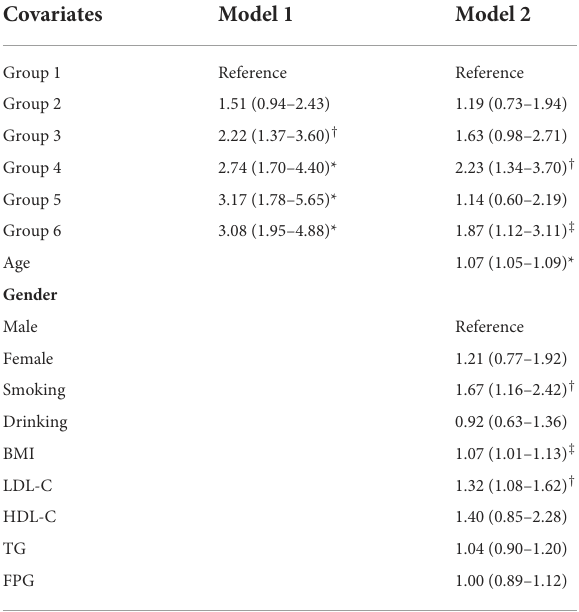
TABLE 3 ORs and 95% CIs of multi-trajectories on CHD risk compared with trajectory group